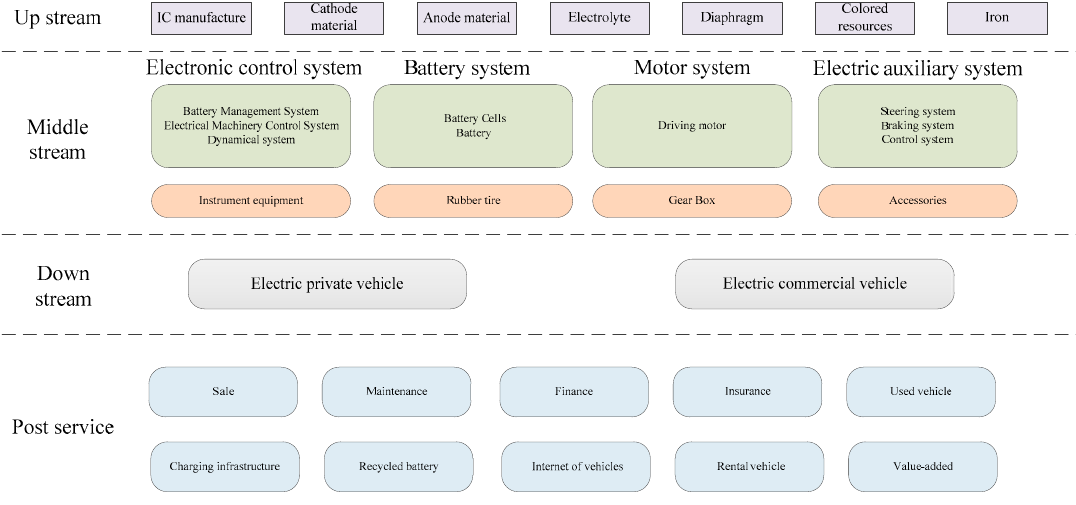
Figure 1. Industry chain of electric vehicles.